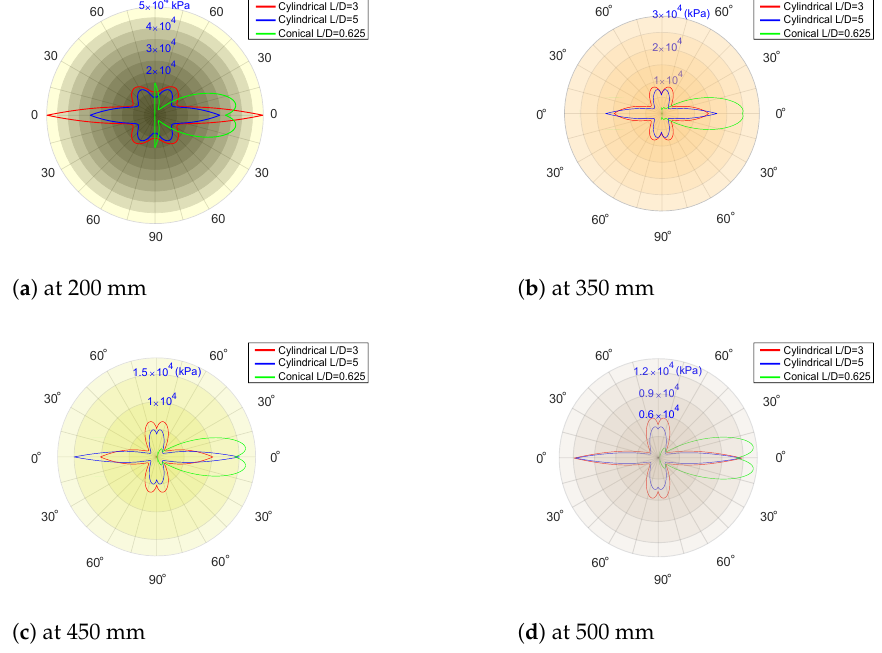
Figure 15. The incident pressure vs. angle orientation for 0.5 kg of pentolite